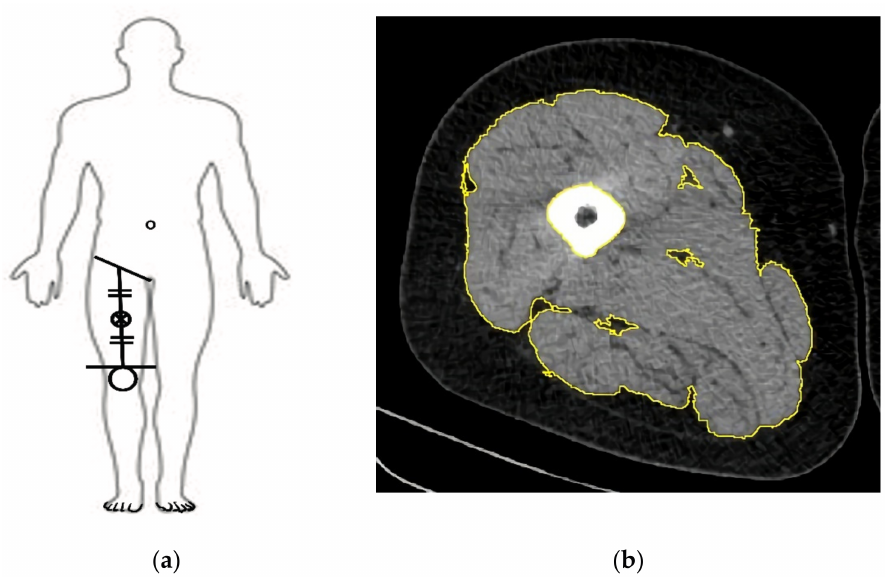
Figure 2. Cross-sectional muscle area (CSMA) determined by mid-thigh CT. ( a ) CSMA was measured at the midpoint from the inguinal crease to the proximal pole of the patella; ( b ) CSA of subcutaneous fat, intermuscular fat, and bone have been removed.